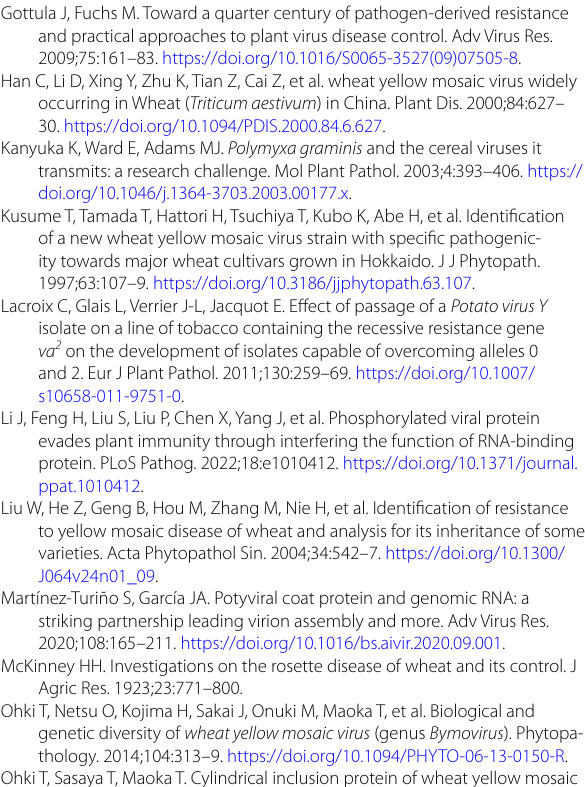
Luohe-2022. Figure S6 . Detection of WYMV by RT-PCR in the inoculated leaves of wheat resistance cultivars after infection with JN-old or JN-2021 and YZ-2016 or YZ-2021 at 7 days post-infiltration (dpi). Figure S7 . The accumulation of WYMV protein in systemic leaves of wheat resistance cultivars inoculated with JN-old or JN-2021 and YZ-2016 or YZ-2021 at 28 days post-infiltration (dpi). Figure S8 . Detection of CWMV by RT-PCR